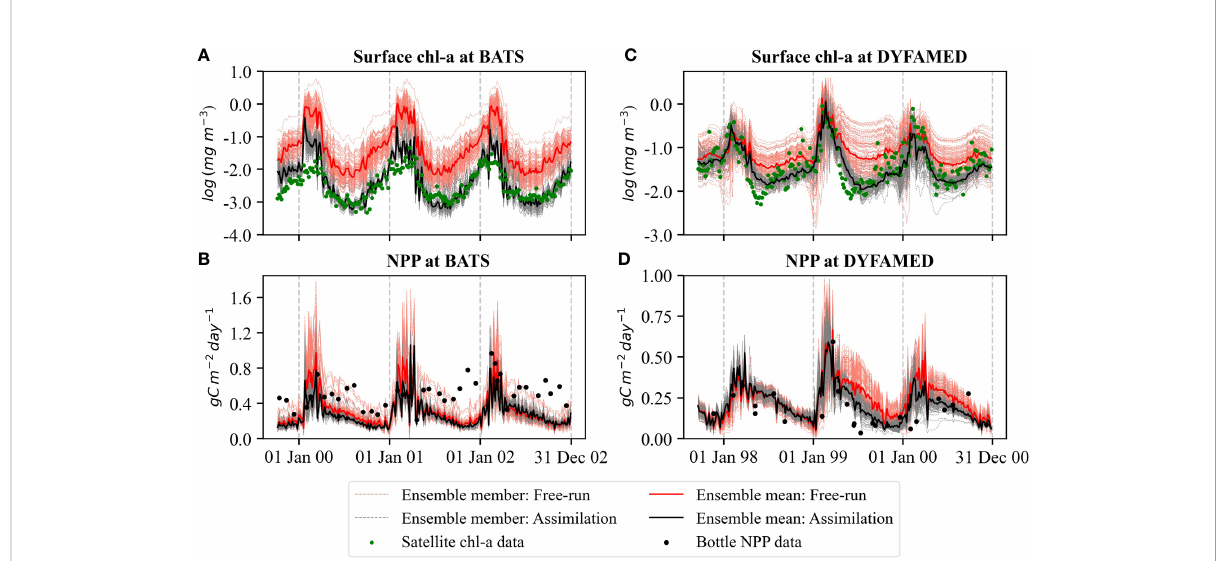
FIGURE 3 The ensemble evaluation of log-transformed surface chl-a concentration at (A) BATS and (C) DYFAMED, and NPP at (B) BATS and (D) DYFAMED for joint state-parameter estimation (EXP Joint_DP ). The red dashed lines show ensemble members for the free-run, and the solid red line shows their mean. Gray dashed lines are ensemble members of the simulation with combined assimilation of satellite surface chl-a and in situ NPP data, and the solid black line is their mean. The green dots represent observations (satellite data for surface chl-a and bottle data for